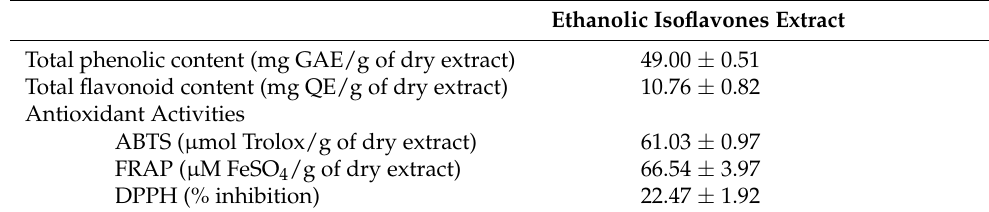
Table 1. The total phenolic content, total flavonoid content, and antioxidant activities of ethanolic isoflavone extracts from